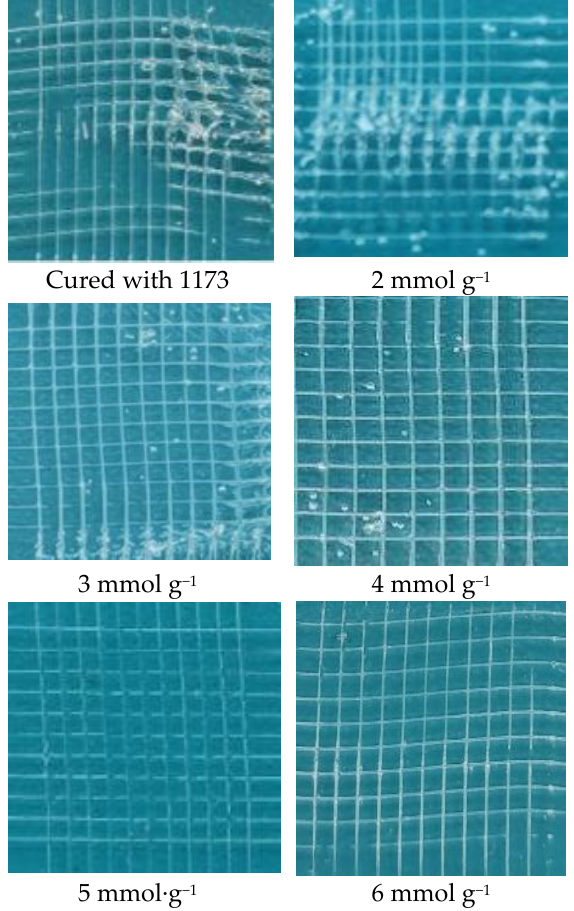
Figure 7. Photos of adhesive tests of coatings cured with 1 wt.% thiol silicone resin with different amount of thiol content.